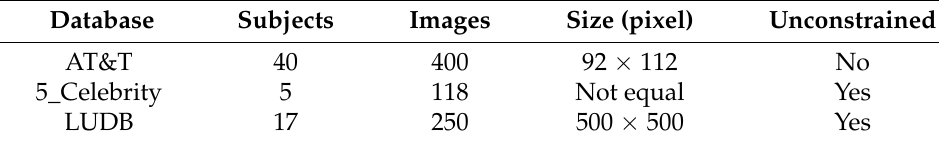
Table 1. Comparison between different dataset used in this study.